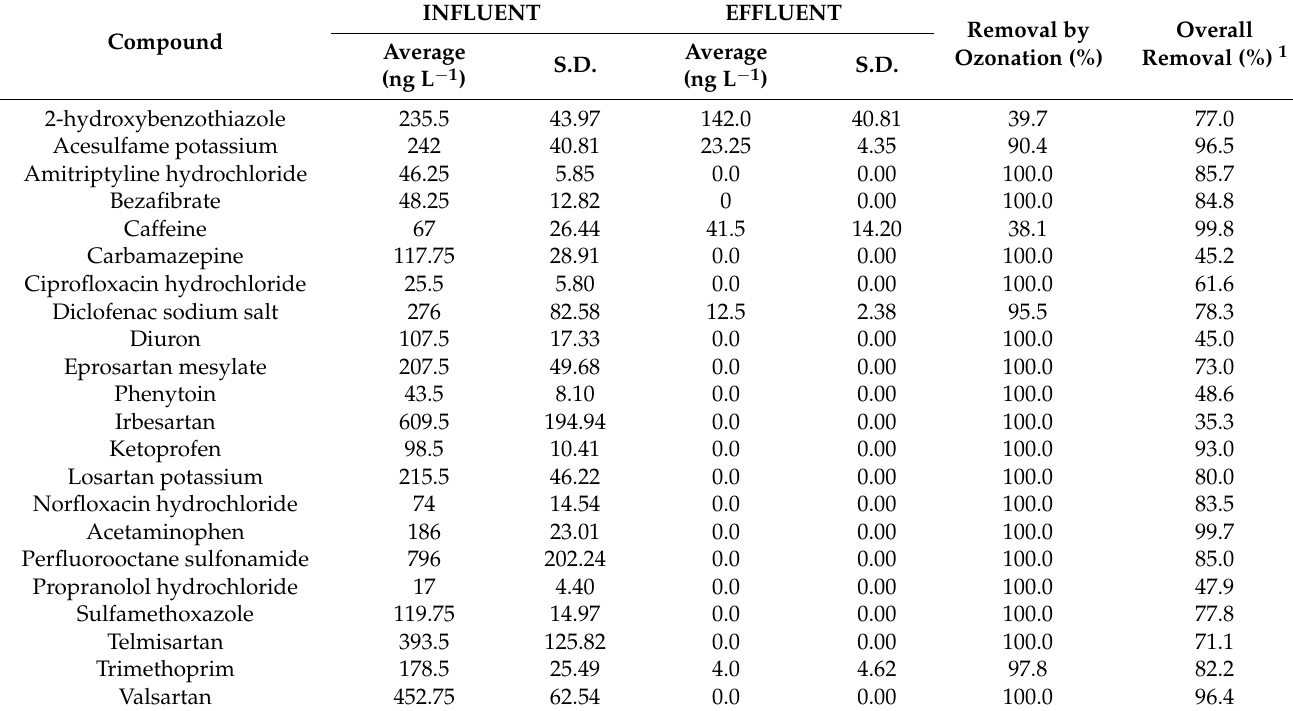
Table 6. Removal yields obtained after ozonation of the CECs identified in the reject stream from the self-cleaning